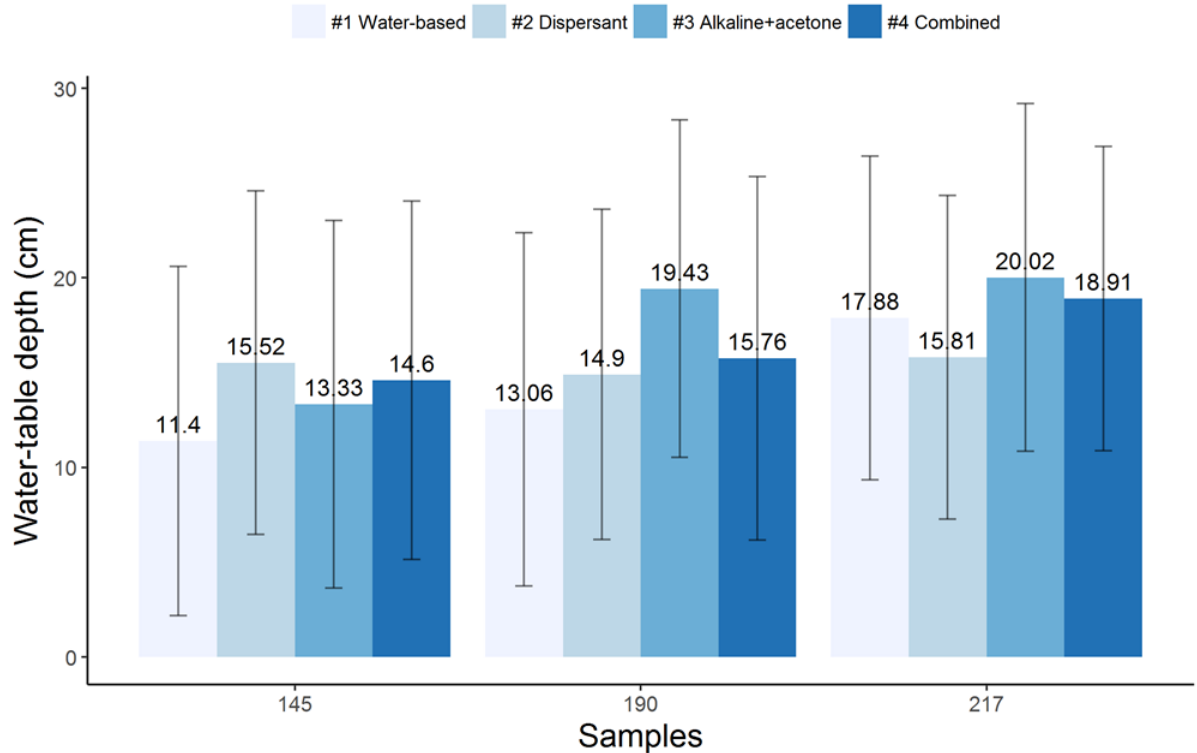
Figure 6. Reconstructed water-table depth using the modern analogue technique method based on a transfer function developed in south-eastern Australia (Zheng et al . 2019). Error bars are sample-specific errors (equivalent to 95 % confidence